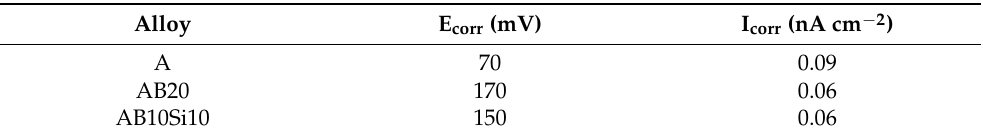
Table 1. Summary of the quantitative analysis of the potentiodynamic polarization test of the A, AB20, and AB10Si10 samples. The estimated error for the corrosion potential is ± 10 mV while for the corrosion current is ± 0.01 nA cm − 2